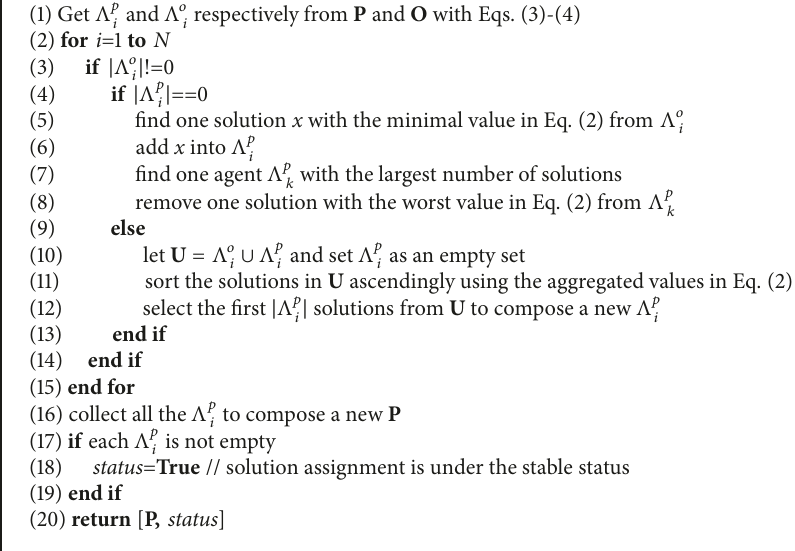
Algorithm 1: CSU( P , O , N ), constrained solution